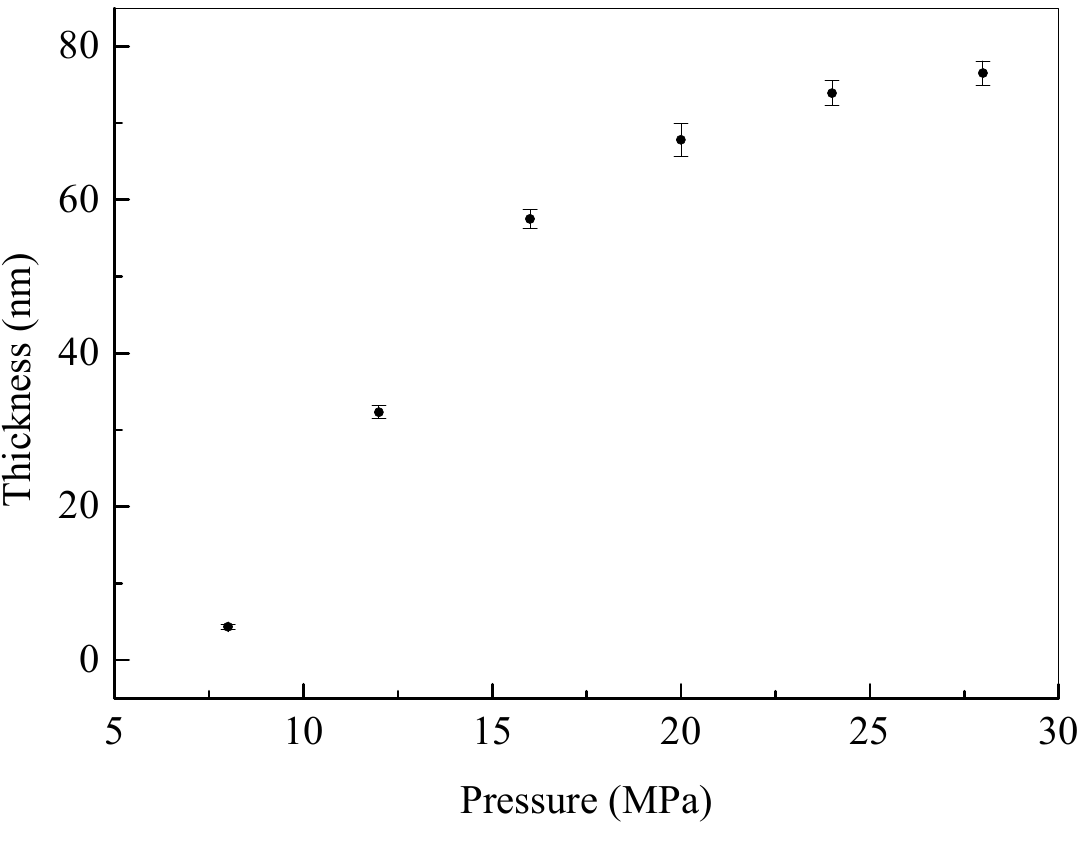
Figure 2. Thickness of barbituric acid-based polysiloxane layer as a function of interpenetration pressure.